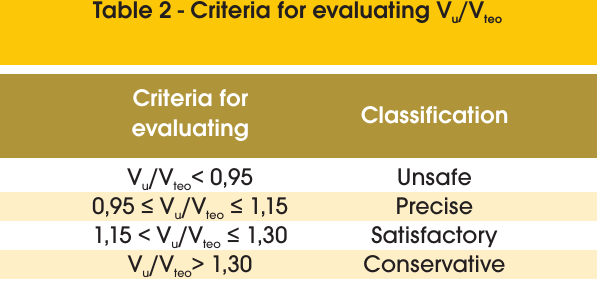
Figure 12 – Example of the estimation of punching shear strength according to the CSCT